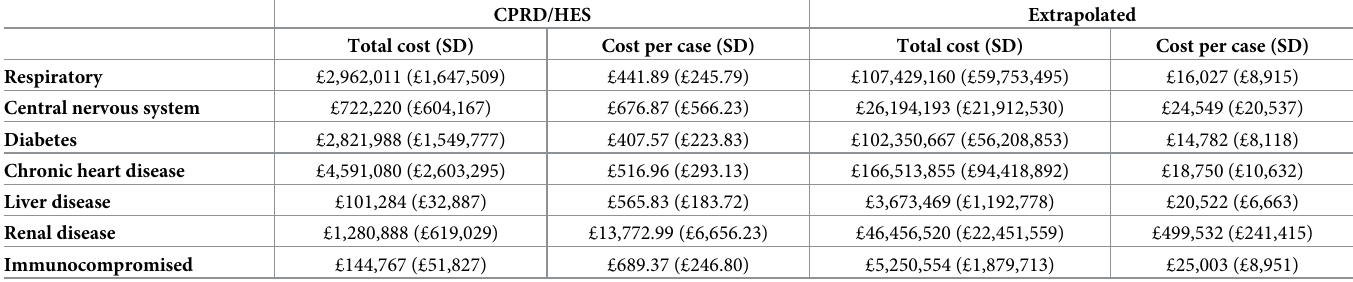
Table 6. Total direct medical cost of acute respiratory illness in high-risk patients during influenza seasons from 2001 to 2009 in the CPRD/HES population and extrapolated to the UK